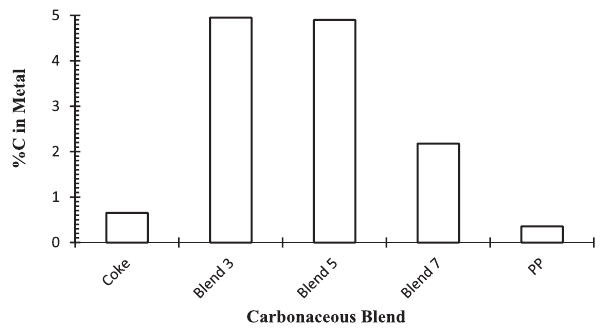
Fig. 11: Carburisation of reduced metal by various reductants at 1500 °C